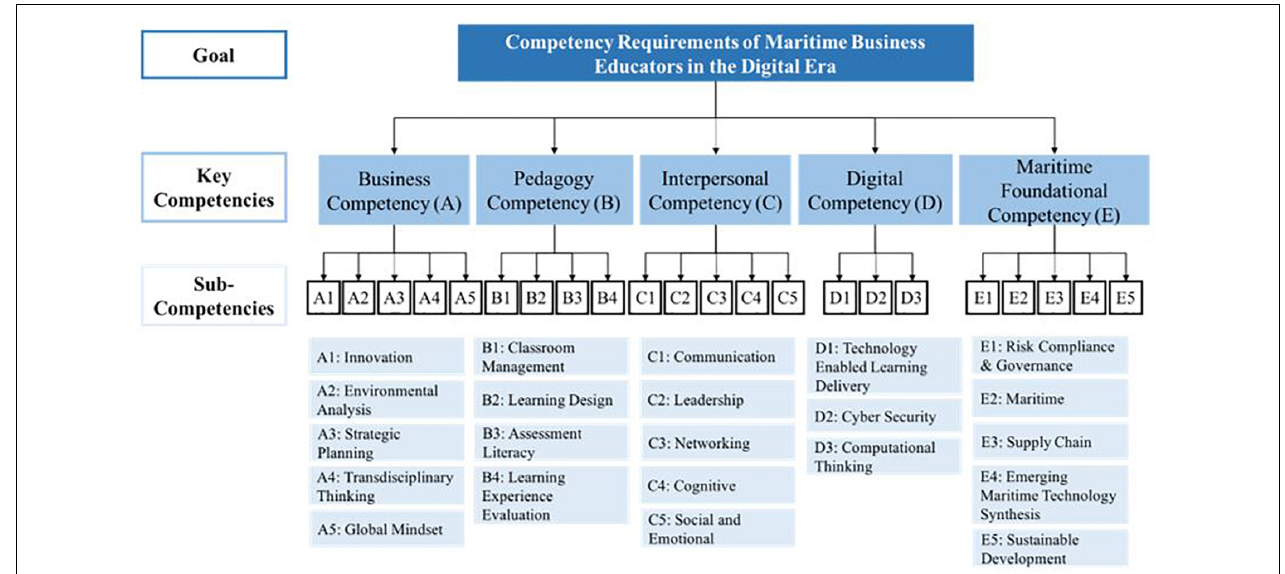
FIGURE 1 | The MBE